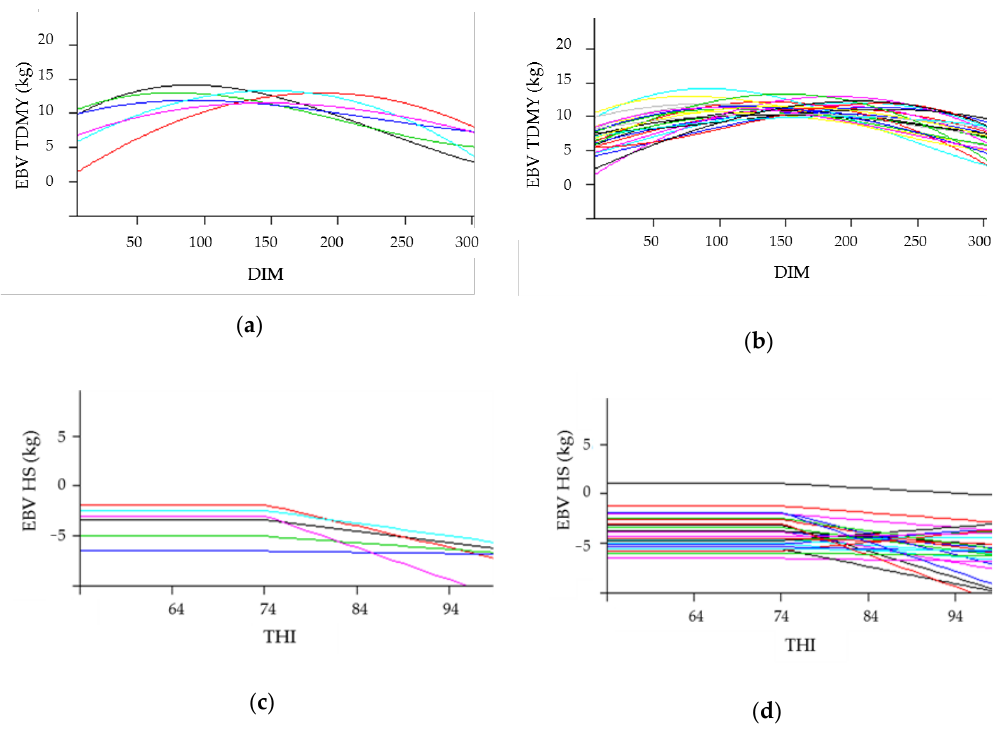
Figure 6. Estimated breeding value gradient (i.e., reaction norm model) for best sires: top 1% ( a ) and top 5% ( b ) for test-day milk yield (EBV_TDMY) and for tolerance to heat stress (EBV_HS) of the same sires ( c , d